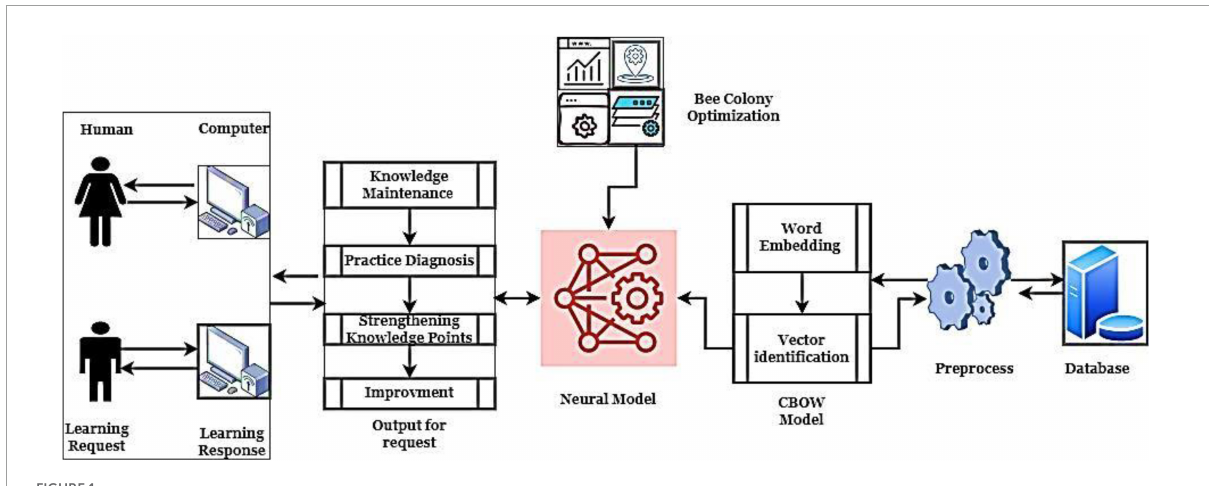
FIGURE1 HCI with ODNN-based AELS